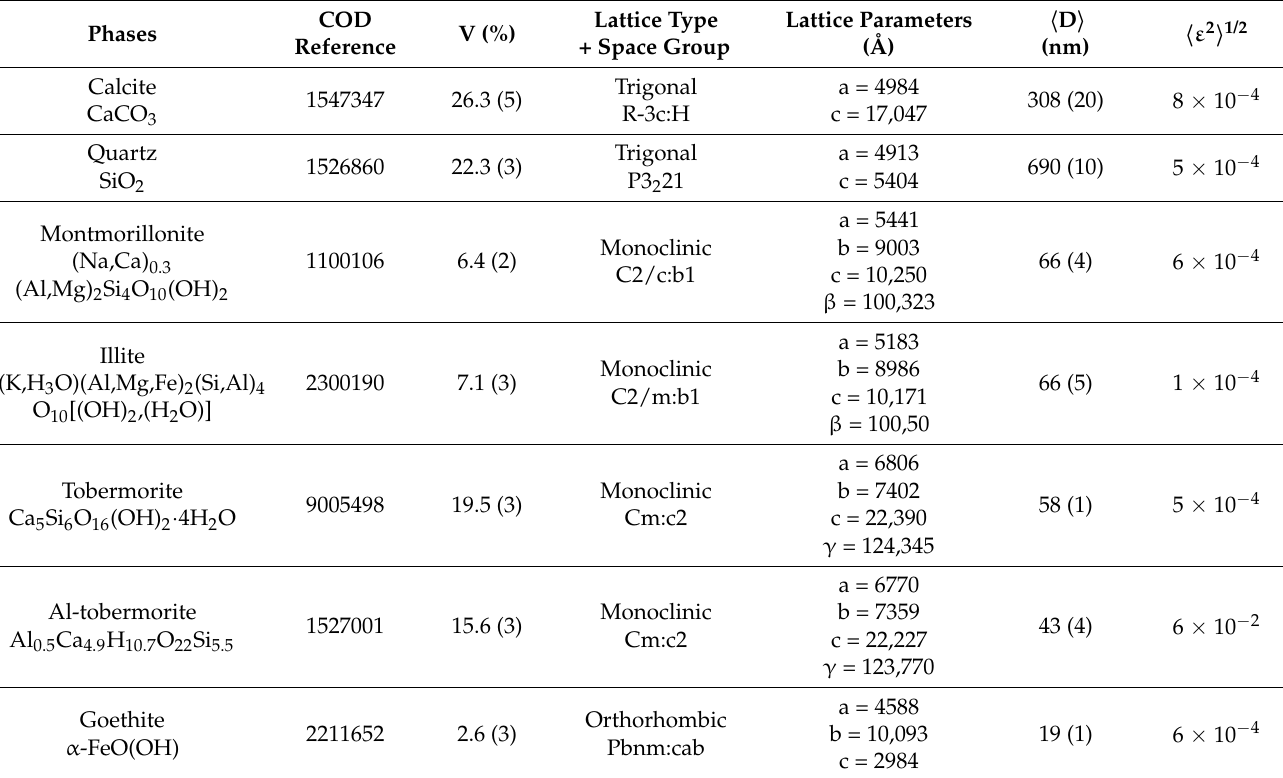
Figure 5. X-ray diffraction diagram of GWM-FA-CR. The calculated diagram (red color) is superim- posed onto the experimental profile (black color). At the bottom, we present the difference curve (I exp –I calc ). Table 8. The mineralogical composition of GWM-FA-CR after 3 weeks of curing.